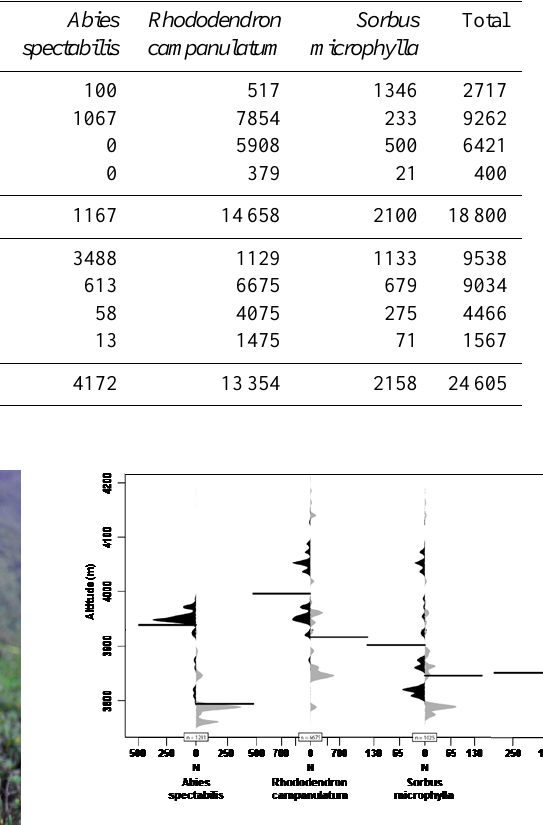
Figure 8. Seedling/sapling density of treeline tree species in the treeline ecotone in Rolwaling Valley according to altitude and slope exposure (black: NE slope; grey: NW slope). tively correlated with soil temperature, germinants, and large shrubs but showed a positive correlation (see Fig. 9). Total soil moisture values did not differ much between NE and NW slopes. study sites in Langtang Valley, ca. 100 km to the west,